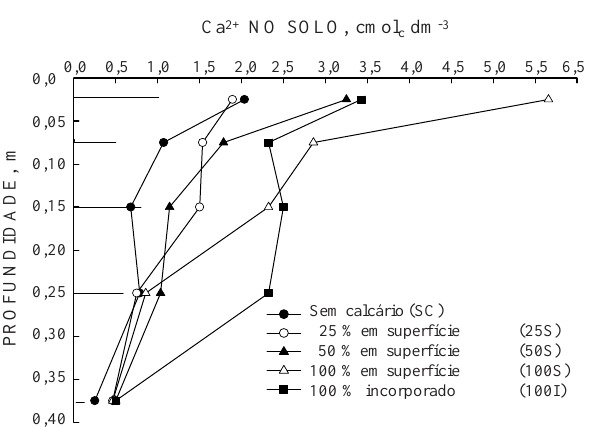
Figura 4. Teores de Mg 2+ em cinco camadas do Argissolo Vermelho distrófico arênico cultivado com milho sob semeadura direta. Barras horizontais representam o DMS.